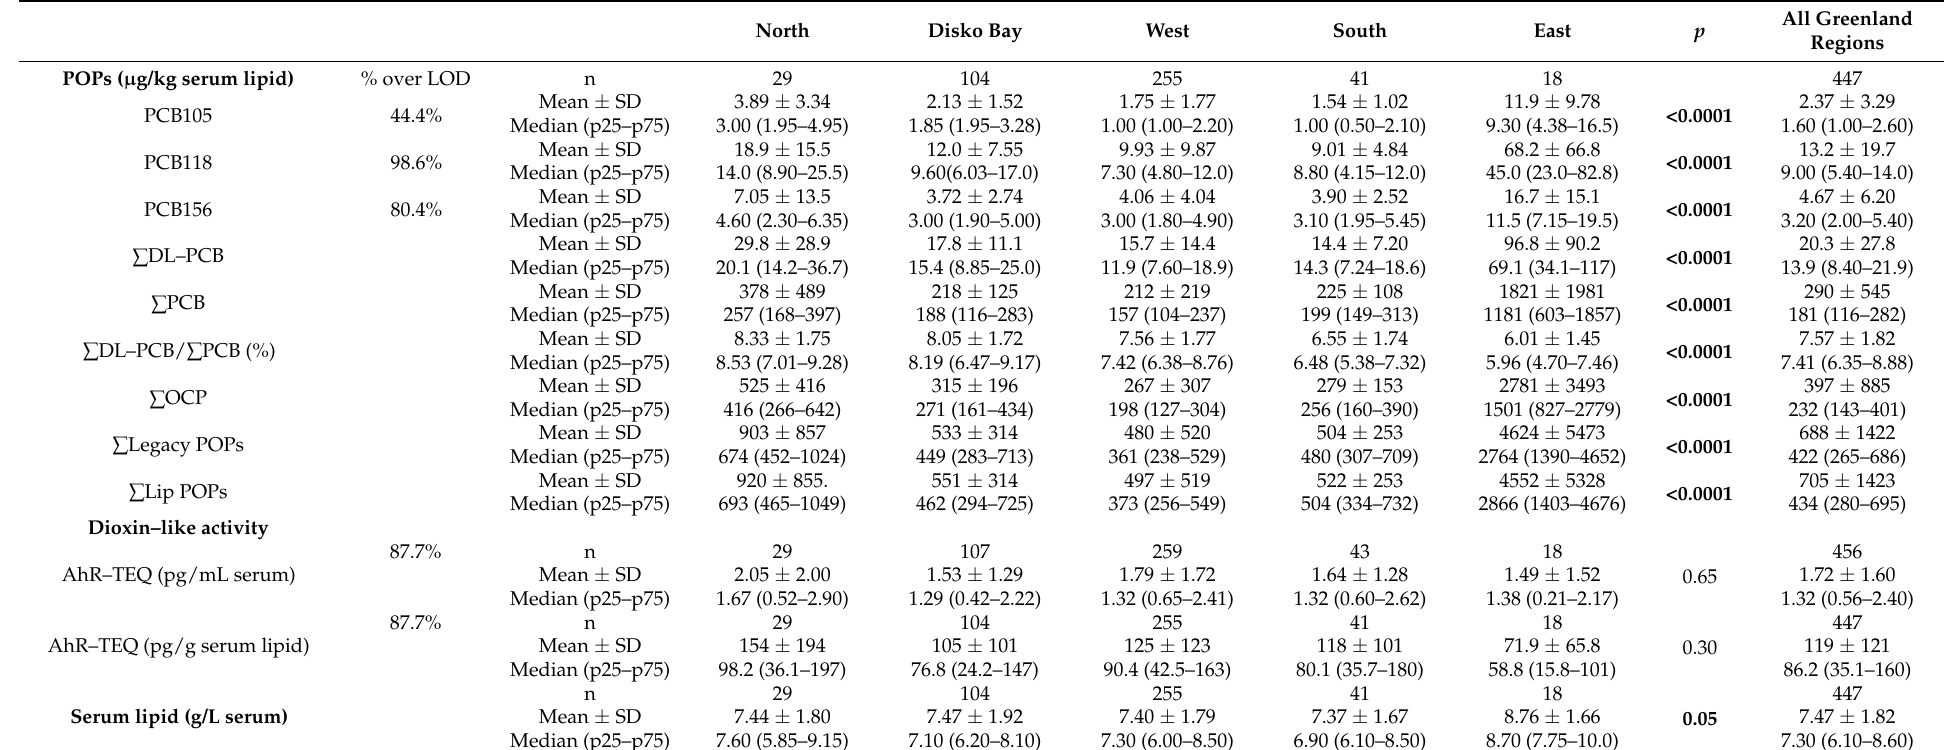
Table 1. Serum levels of lipophilic POPs and AhR-TEQ in ACCEPT pregnant